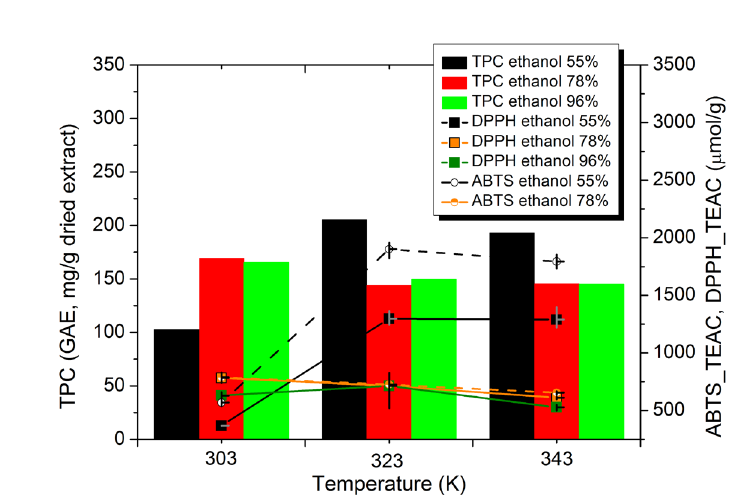
Figure 6. The influence of temperature on: a) the total polyphenolic content expressed as gallic acid equivalents (GAE, mg g -1 dried extract) vs. ethanol 55%, 78% and 96%; b) antioxidant capacity of the 55% and 78% ethanol extracts expressed as Trolox equivalents (TEAC, µ mol g -1 ) vs. ABTS and DPPH assays; Time: 60 min, Quantity of plant material: 1 g.